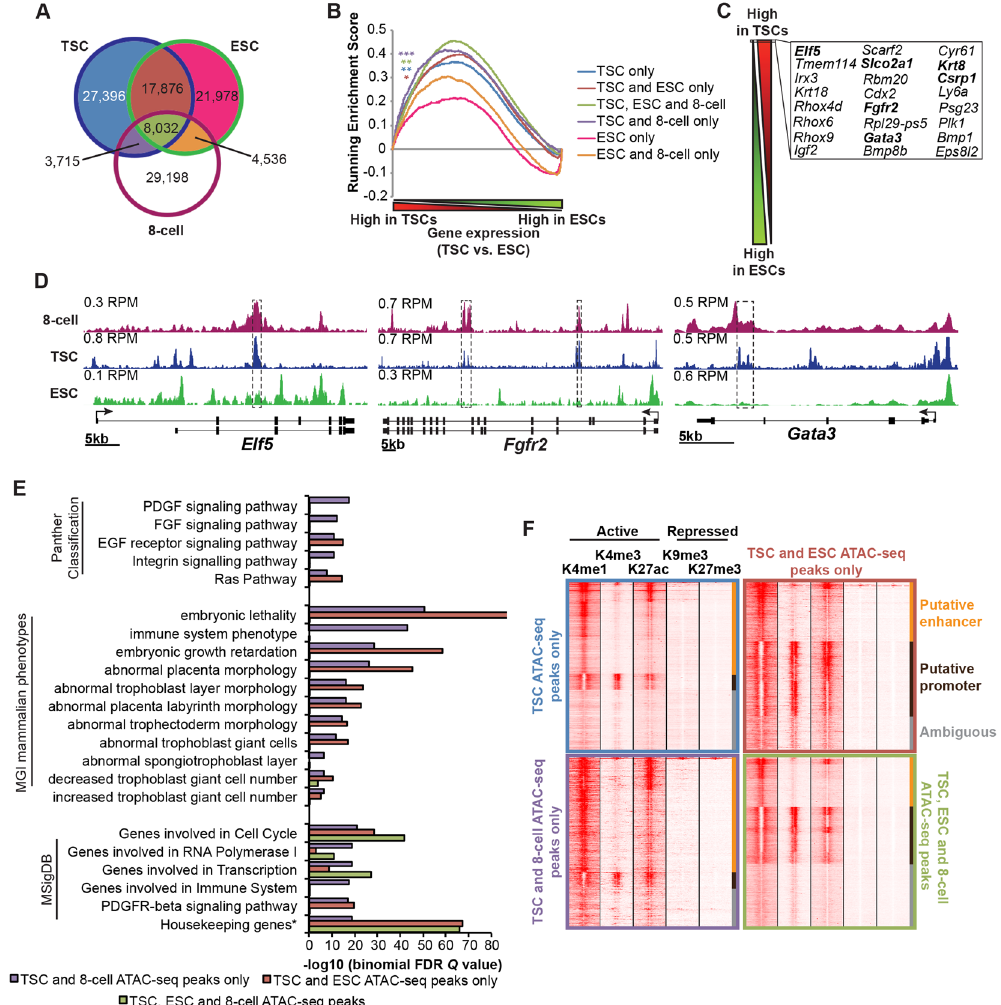
Figure 1. A subset of TSC cis -regulatory elements is apparent at the 8-cell stage. ( A ) Partially overlapping TSC, ESC and 8-cell ATAC-seq peaks. See also Supplementary Figure S2. ( B ) Gene Set Enrichment Analysis comparing TSC and ESC gene expression microarrays with each subset of ATAC-seq peaks shown above in A (nearest TSS ± 100 kb from each peak annotated). * P ≤ 2 × 10 − 2 , FWER P ≤ 1 × 10 − 2 ; ** P ≤ 1 × 10 − 2 , FWER P ≤ 1 × 10 − 2 ; *** P ≤ 1 × 10 − 3 , FWER P ≤ 3 × 10 − 3 . ( C ) Top 24 genes with significantly higher expression (by fold change and adjusted P value < 1 × 10 − 9 – see Supplementary Table S2) in TSCs vs. ESCs. Genes with regions selectively accessible in both TSCs and 8-cell embryos are in bold. ( D ) ATAC-seq tracks at Elf5 , Fgfr2 and Gata3 . Regions selectively accessible in both TSCs and 8-cell embryos are boxed. RPM = Reads per million. ( E ) TSC ATAC-seq peaks shared with 8-cell embryos occur proximal to genes with functions consistent with placenta development and are relatively underenriched for housekeeping functions. Analysis of TSC ATAC-seq subsets indicated in Fig. 1A using GREAT 84 . The nearest TSS ± 100 kb from each peak was annotated. Selected Panther, MGI phenotypes and MSigDB terms are shown. * “Housekeeping genes identified as expressed across 19 normal tissues”. Note: ATAC-seq peak subsets not represented e.g. unique TSC peaks are too large for statistically meaningful analysis by GREAT 84 . ( F ) Heatmap of H3K4me1, H3K4me3, H3K27ac, H3K9me3 and H3K27me3 ChIP-seq data at subsets of TSC ATAC-seq peaks as defined by Fig. 1A. Broadly, H3K4me1, H3K4me3, H3K27ac are considered to be “active” histone marks, with H3K4me1 marking enhancer and H3K4me3 promoters, while H3K9me3 and H3K27me3 are repressive marks 88 . TSC ATAC-seq peaks are defined at “putative enhancer” based on strong H3K4me1 signal relative to H3K4me3, and “putative promoter” based on strong H3K4me3